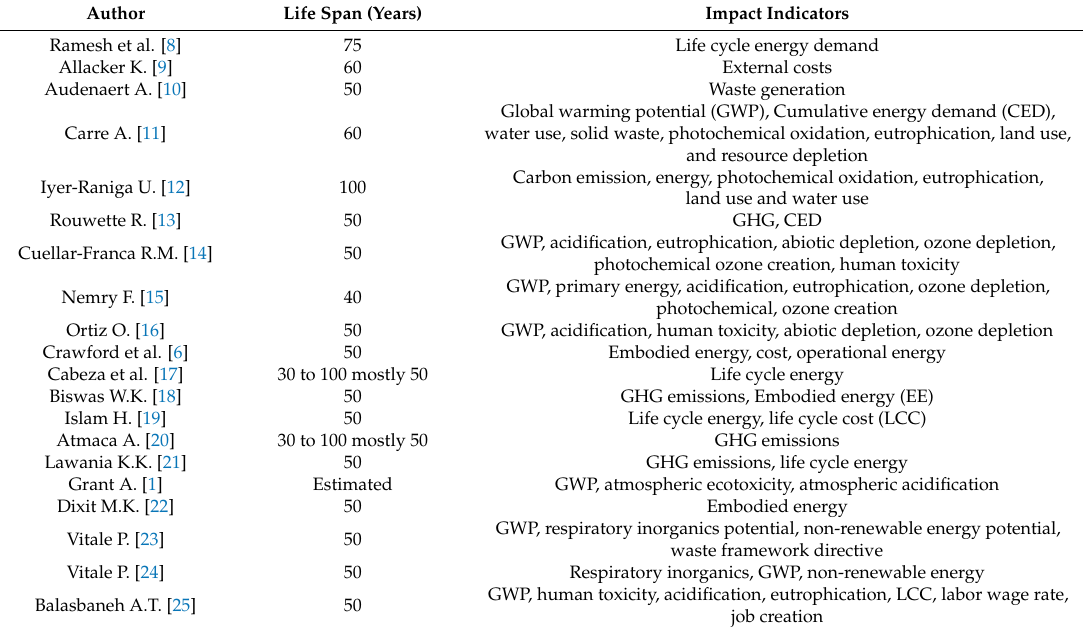
Table 1. Existing case